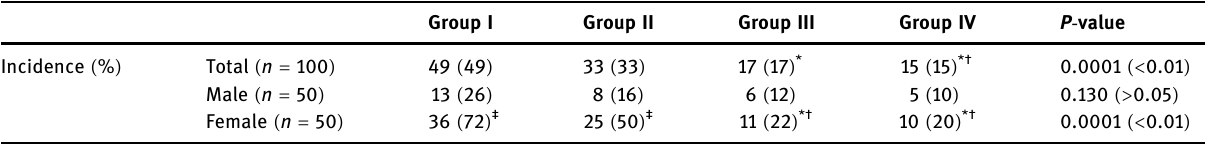
Table 2: The incidence of dexamethasone - induced perineal irritation